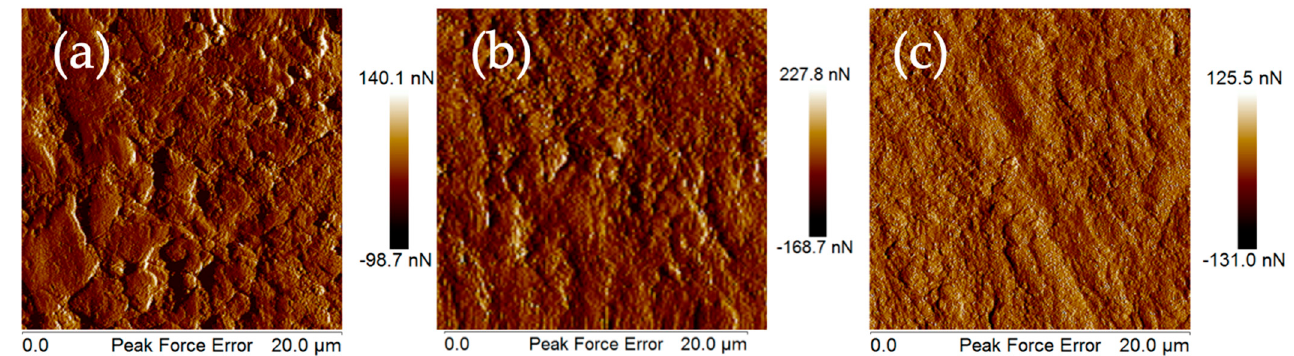
Figure 12. AFM topographic maps acquired in peak force error mode in sample C-2: ( a ) varnish layer 1; ( b ) cinnabar layer 2; ( c ) gypsum ground layer 3.